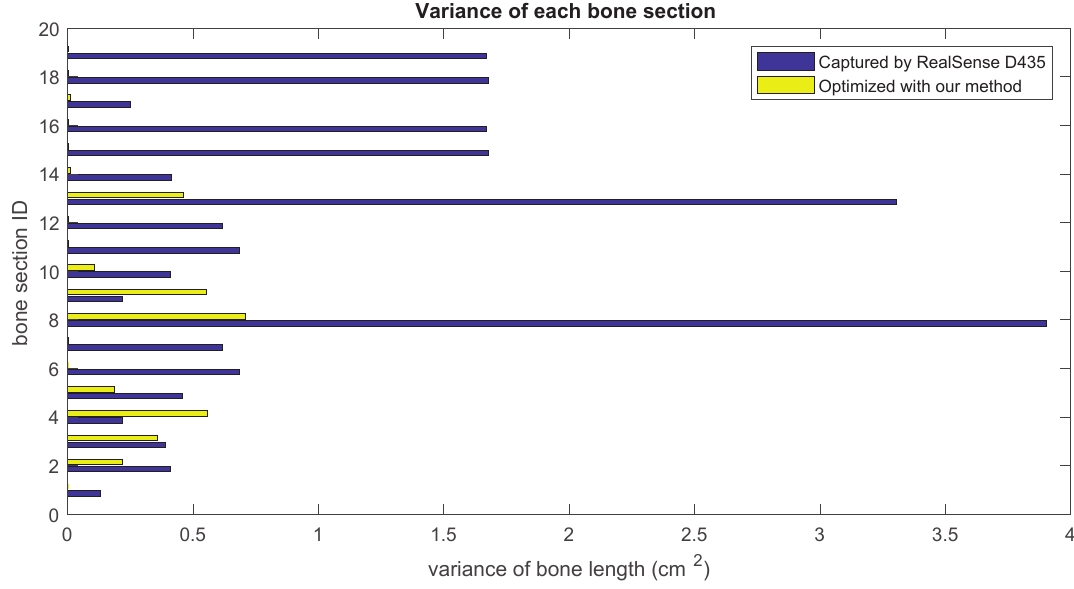
Figure 14. The summation of the bone length variance for each bone section over all frames. Purple: variance of the bone length captured with Nuitrack SDK for RealSense D435. Yellow: variance of the optimized bone length after applying our